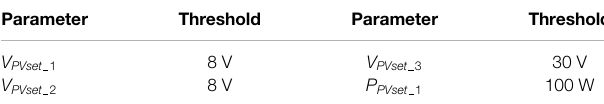
TABLE 1 | Preset threshold values.